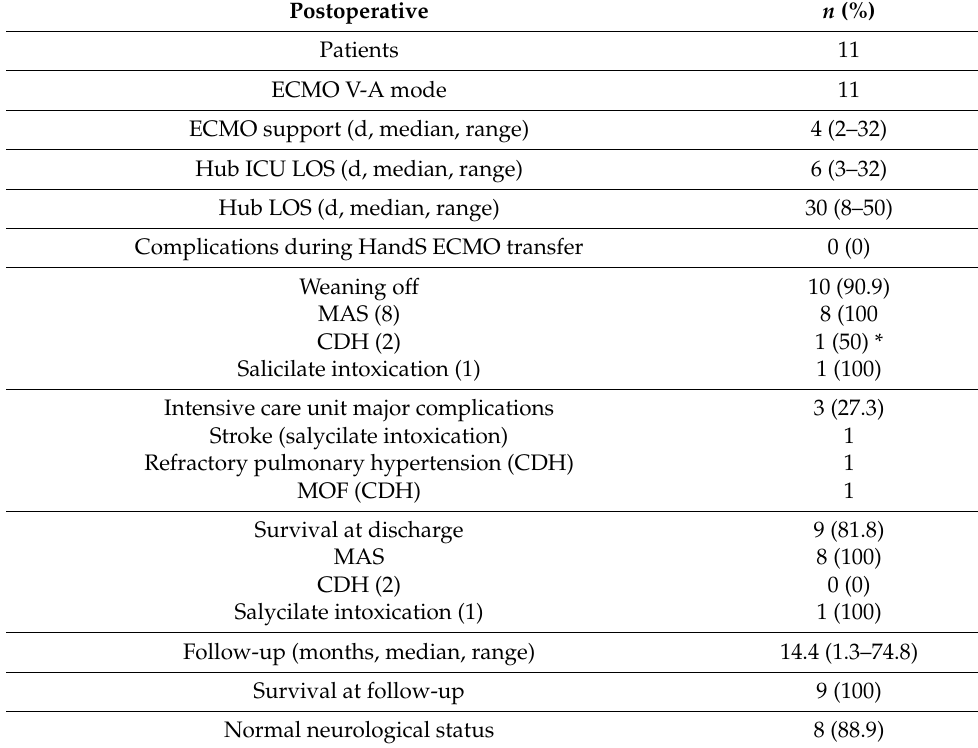
Table 3. Postoperative and follow-up data.